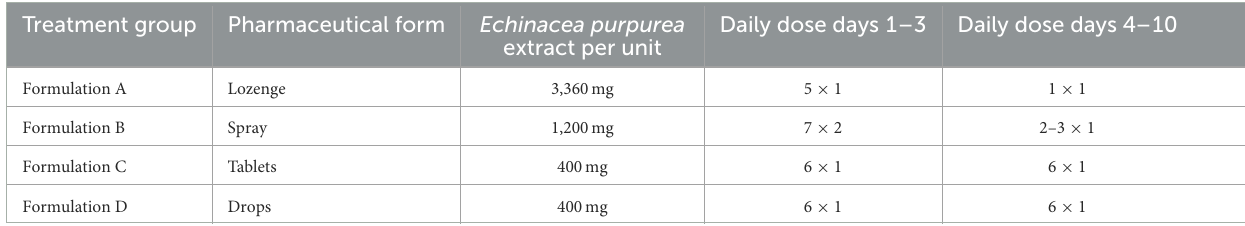
TABLE 2 Dosing of treatments: new Echinacea formulations (A and B) and conventional Echinacea formulations (C and D). Treatment